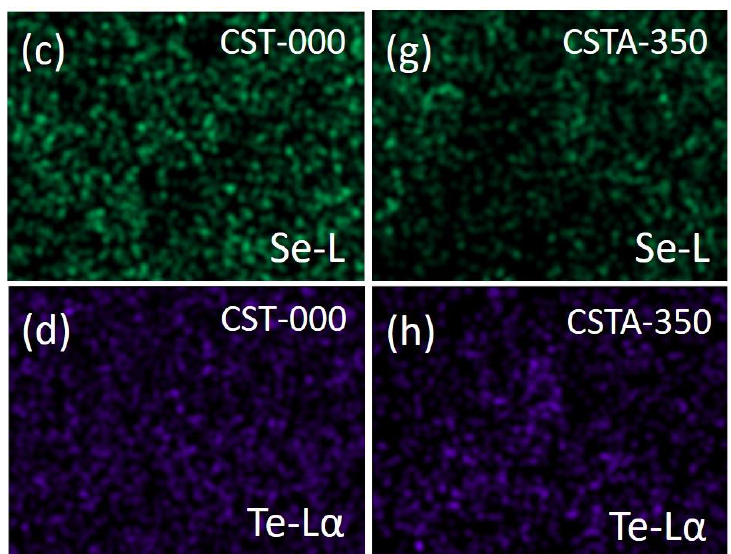
Figure 3. ( a – h ) EDS and elemental mapping of non-annealed and optimized annealing temperature at 350 ° C of CdSe 0.6 Te 0.4 , respectively.